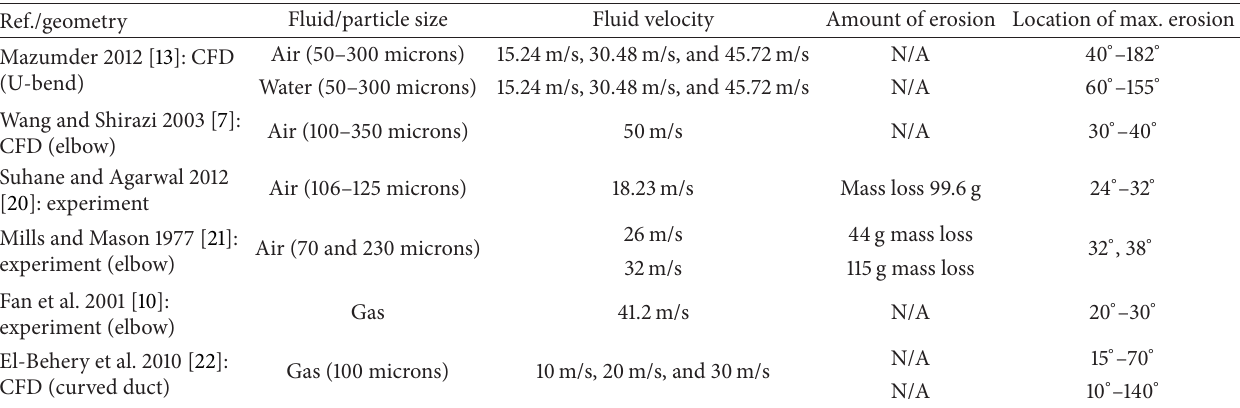
Table 2: Comparison of available literature data.